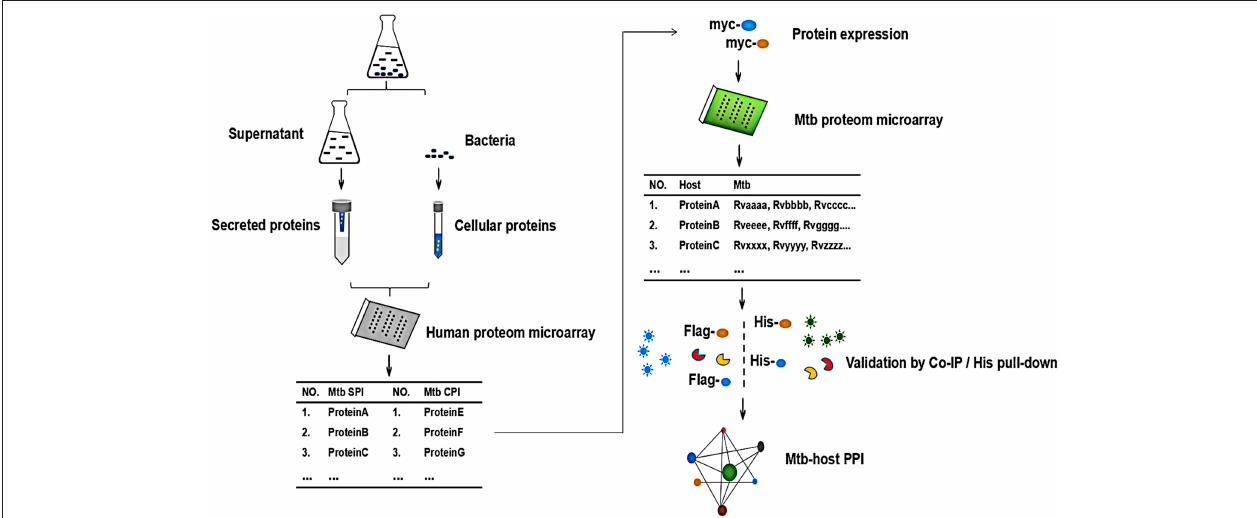
FIGURE 1 | The schematic diagram of the proteome microarray strategy for identification of Mtb -human PPI. Briefly, the Mtb secreted protein (SP) and cellular protein (CP) were prepared and labeled with distinct fluorescein, respectively. After incubated with human proteome microarray, the potential Mtb interactors were screened. To call for Mtb effectors, human proteins were expressed and purified in vitro , reversely incubated with Mtb proteome microarray. Following experimental validation by His pull-down assay and Co-IP determined the interactions and the Mtb -host PPI.